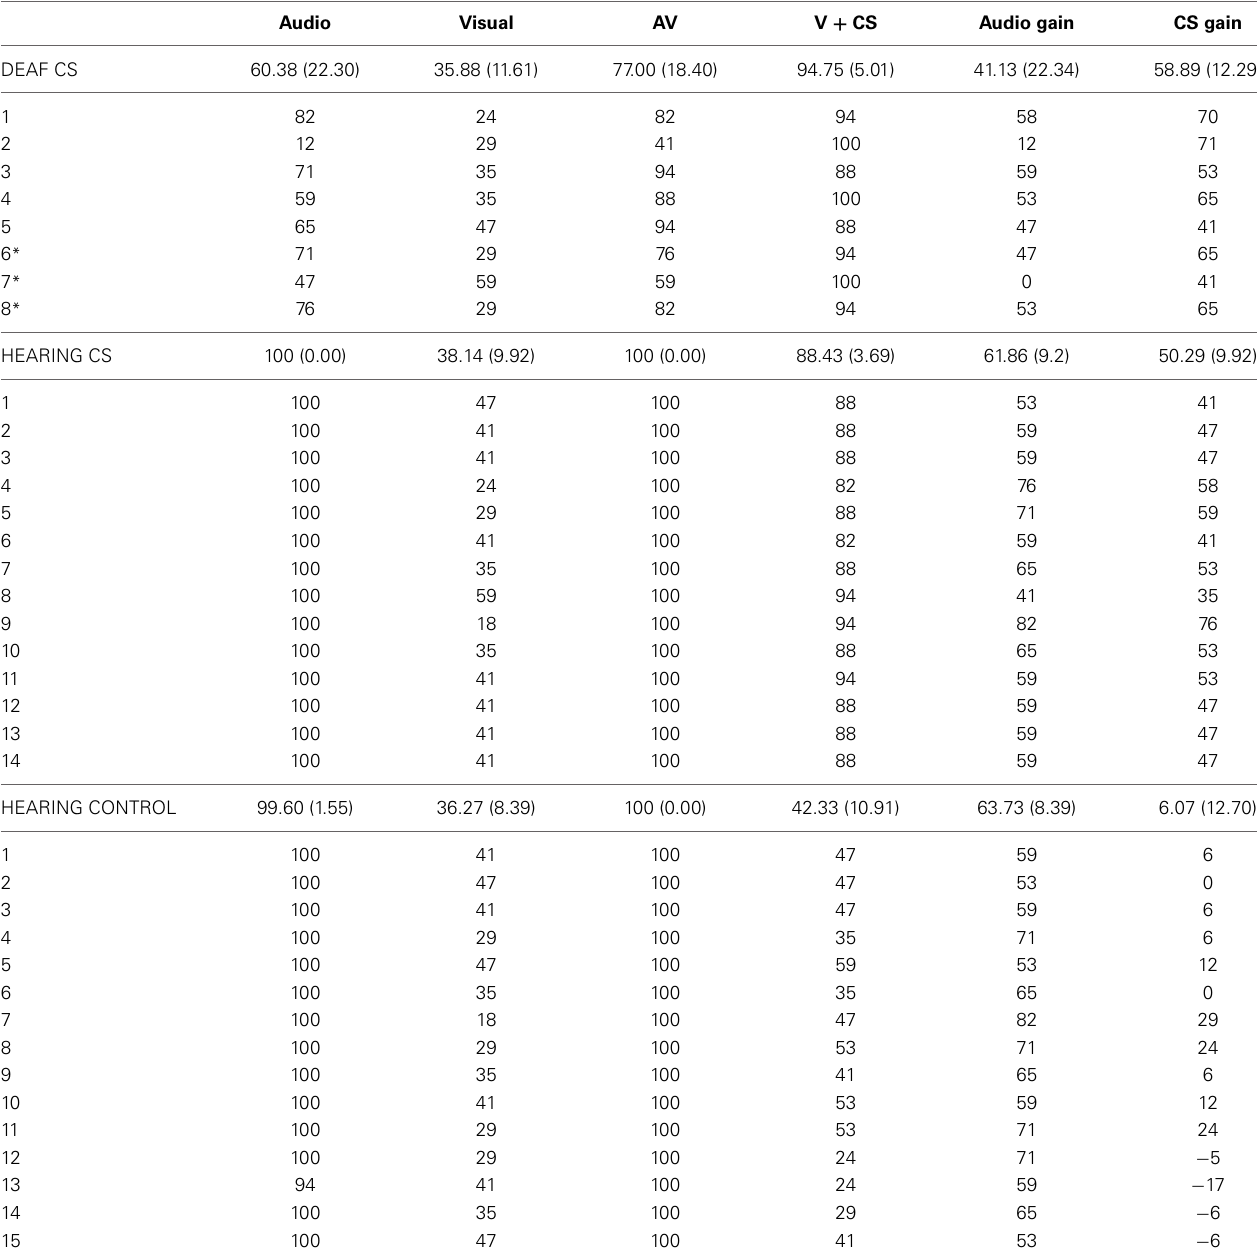
Table A1 | TERMO scores by group and participant for Audio-Only, Visual-Only, AV, and Visual with CS (V + CS) cue conditions.